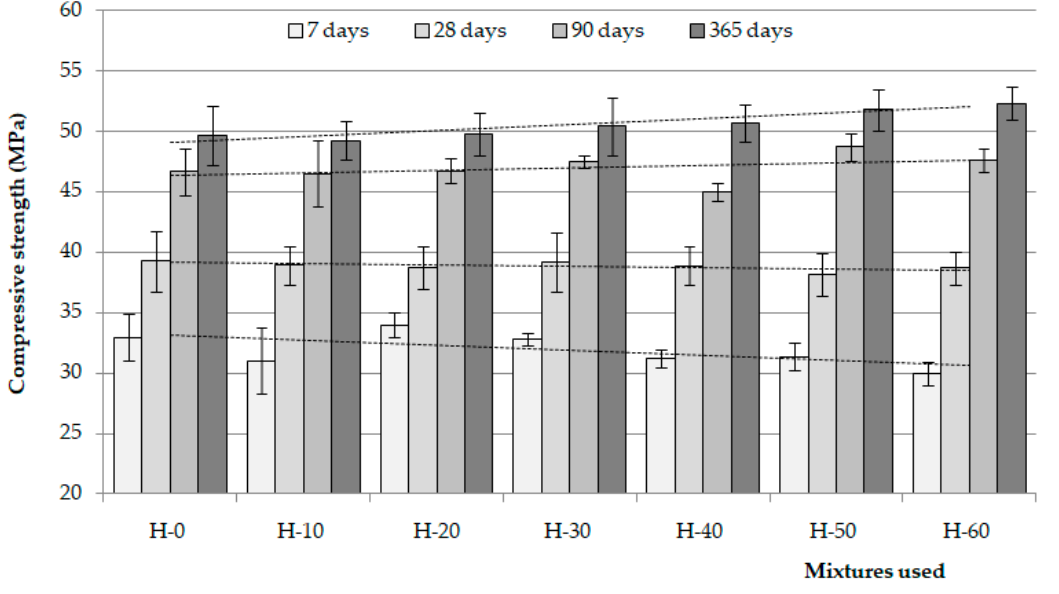
Figure 12. Histograms with dispersions of results.